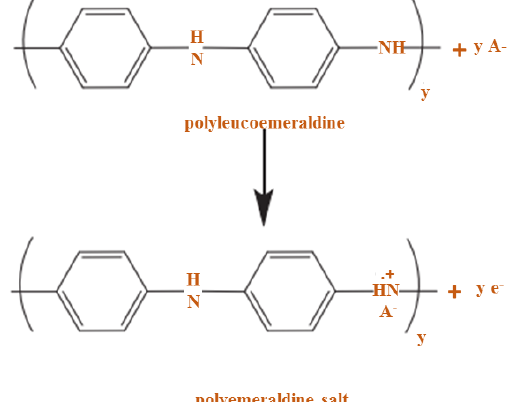
Figure 12. Doping oxidative with chlorine. Reproduced from Eur. Polym. J., 125, Kumari Jangid, N.; Jadoun, S.; Kaur, N., A review on high-throughput synthesis, deposition of thin films, and properties of polyaniline, Copyright (2020), with permission from Elsevier.